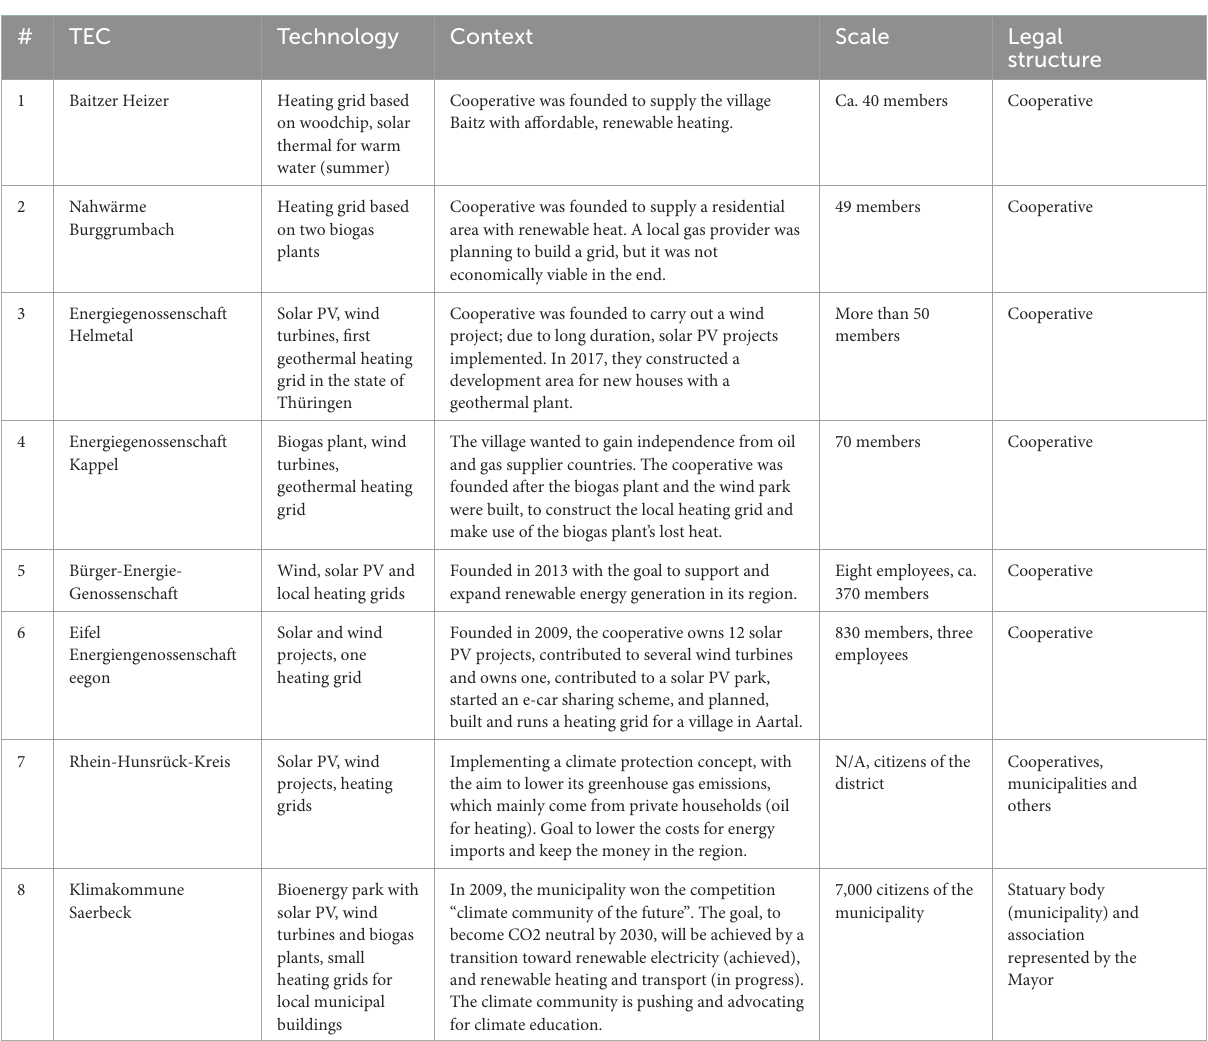
TABLE 1 Interviewed actors from TEC